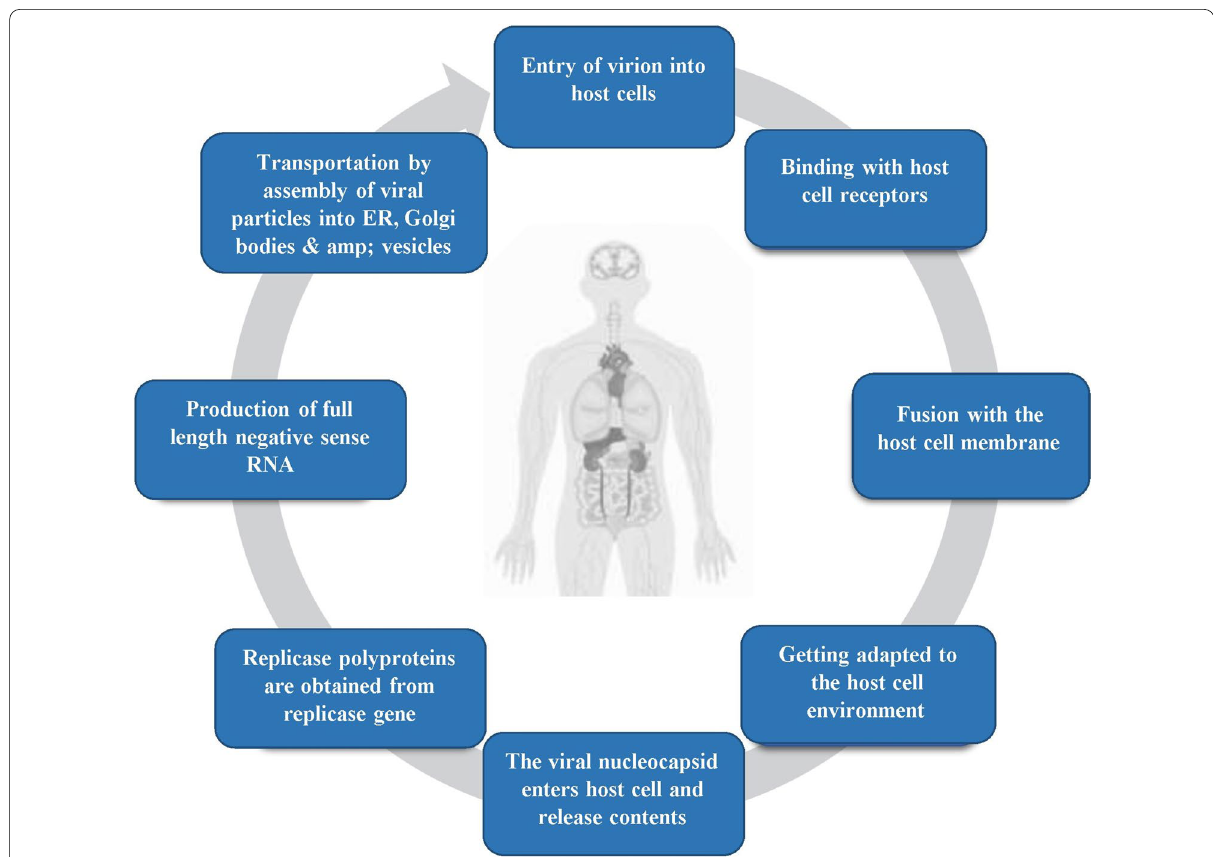
Fig. 5 Life cycle of SARS-CoV-2